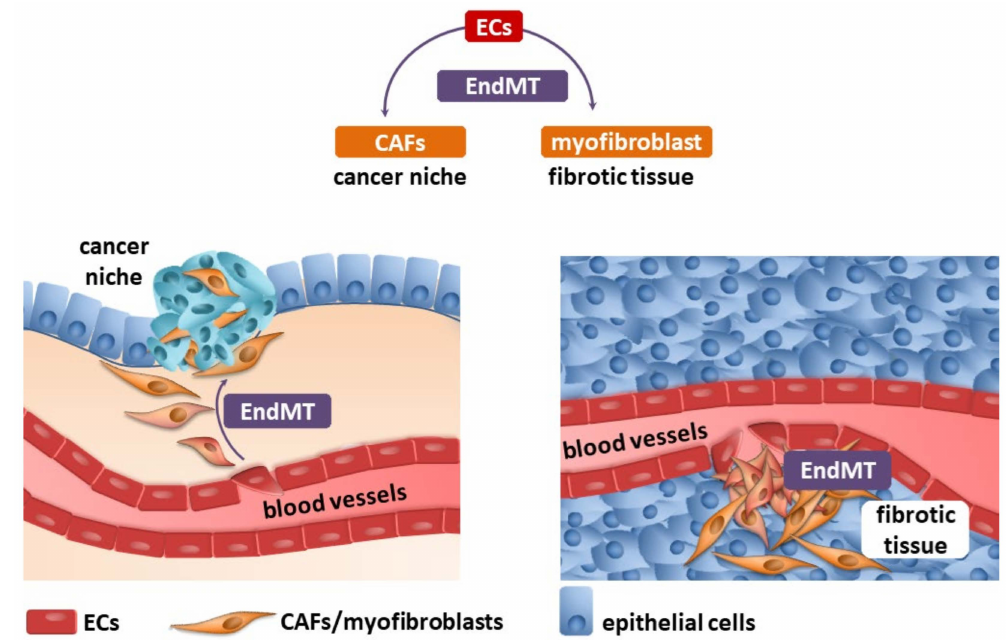
Figure 1. Endothelial cells (ECs) undergo an endothelial–mesenchymal transition (EndMT), which are the source of cancer-associated fibroblasts (CAFs) and myofibroblasts (detailed description in the